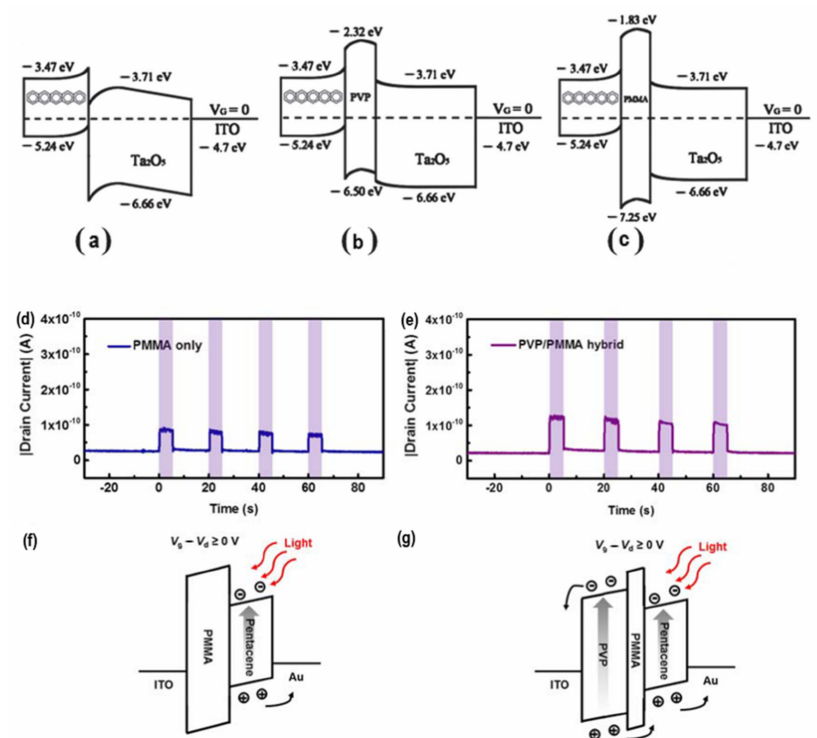
Figure 9. ( a – c ) indicate the energy band diagrams of unmodified, PVP-modified and PMMA-modified OPT memory in darkness. Reprinted with permission from ref. [103]. Copyright 2012 Royal Society of Chemistry. ( d , e ) illustrate dynamic photoresponsive behaviour of OPTs (PMMA and PVP/PMMA gate insulator), ( f , g ) show the operating principles